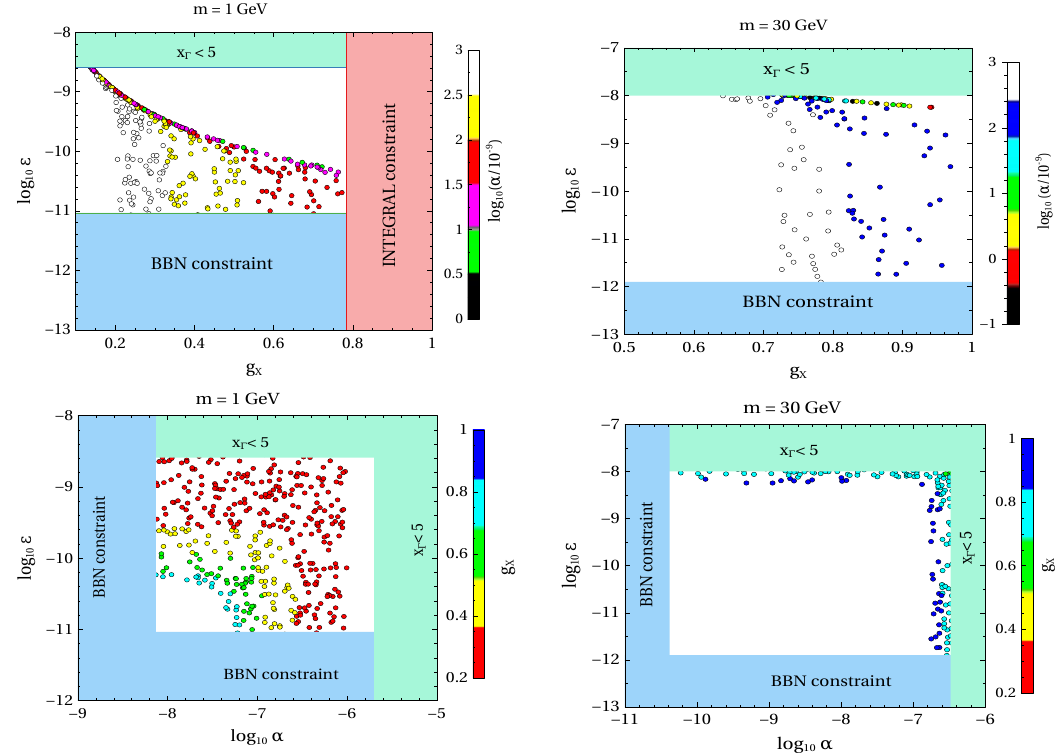
Figure 8 . Upper panel : parameter space in (cid:15) − g X plane reproducing the observed relic density in 2 σ range for m = 1 GeV and 30 GeV. Green and blue shaded regions are disalllowed from thermalisation condition and BBN constraint respectively. Lower panel : allowed (cid:15) − α parameter space for m = 1 GeV and 30 GeV. Color codes are same as upper